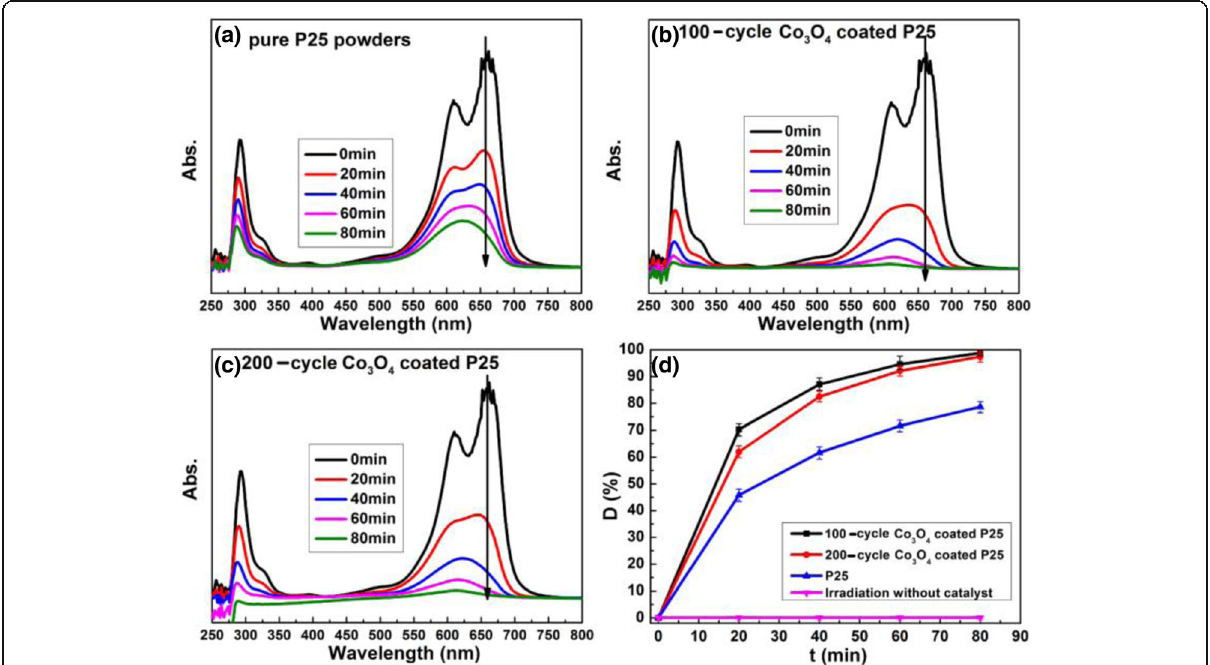
Fig. 5 UV-visible absorption and degradation curves of MB solution with various catalysts. a Pure P25. b 100-cycle Co 3 O 4 . c 200-cycle Co 3 O 4 -coated P25 catalyst. d Degradation curves of MB